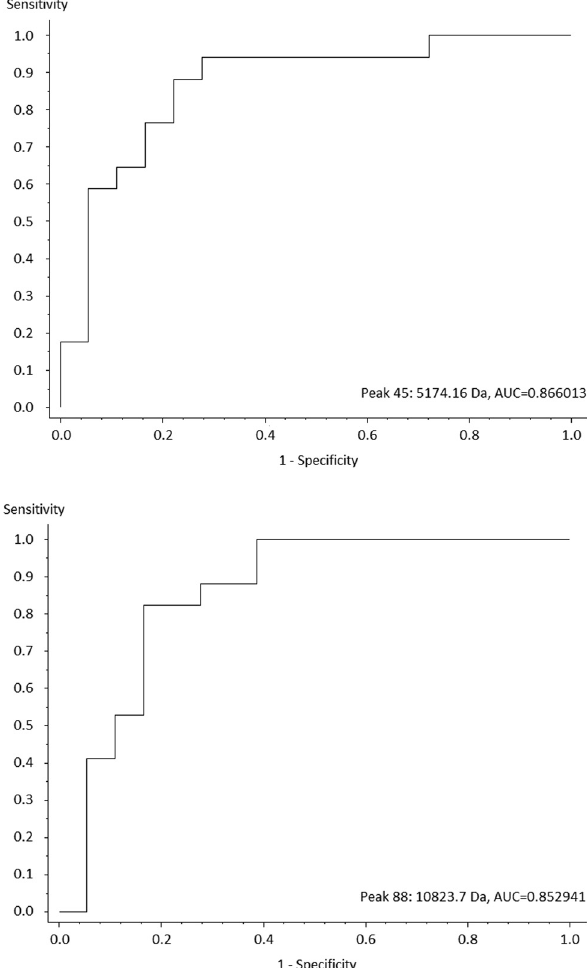
Figure 3: Plots of ROC curves representing the relationship between sensitivity and speci fi city of m / z peaks 5174.2 and 10823.7. Areas under the ROC curves ( AUC ) are 0.866013 and 0.852941,